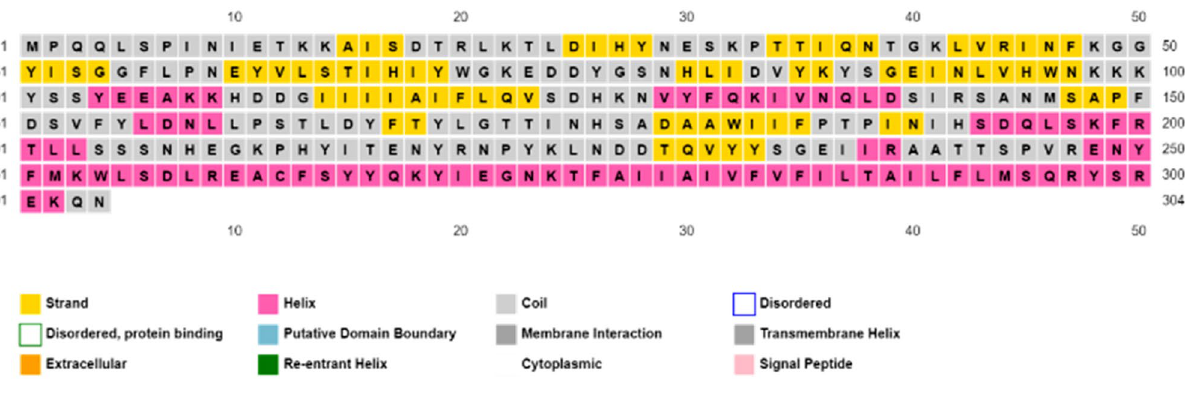
Figure 5. Secondary structure